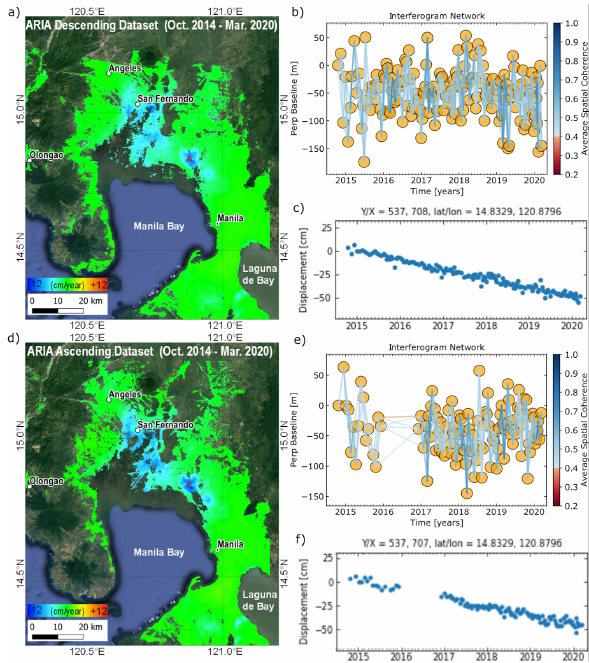
Figure 3. MintPy processed displacement time series over Manila region (Philippines) derived from Sentinel-1 ARIA products for the period between October 2014 and March 2020. a) and d) average displacement velocity maps along the LOS direction for descending and ascending orbit path acquisitions. A coherence mask greater than 0.6 was applied. Red triangles represent the displacement time series plotted in c) and f). b) and e) network of interferograms for descending and ascending datasets. Background imagery for a) and b) Google Earth Image Landsat/Copernicus, Map data ©2021.